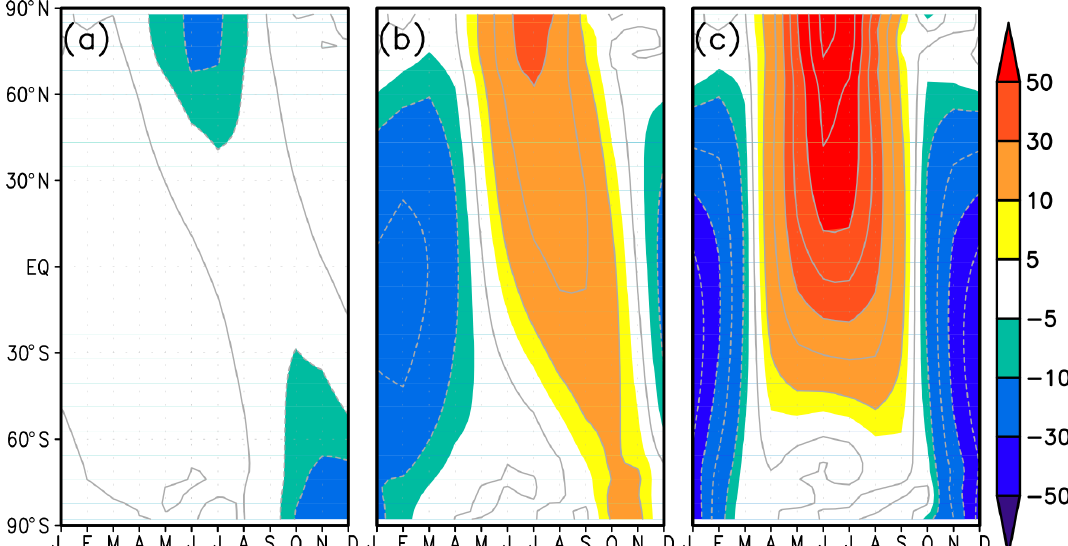
Figure 3. Variation of incoming shortwave solar radiation anomaly relative to PI (unit: Wm − 2 ) with season and latitude for (a) LGM, (b) 6ka, and (c)